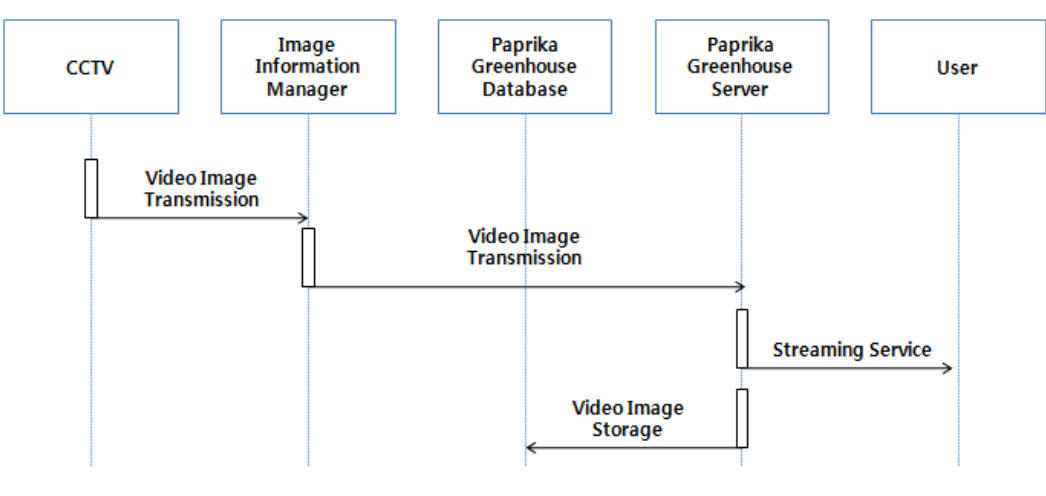
Figure 3. Paprika Image Monitoring